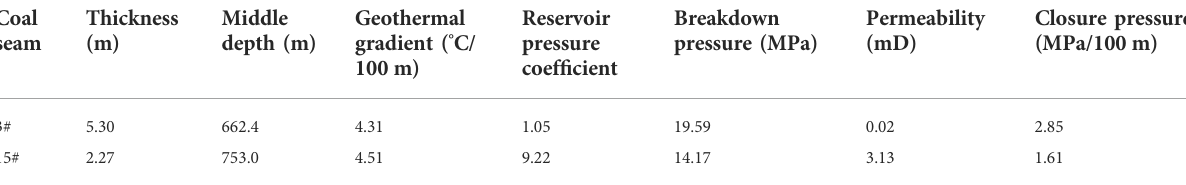
TABLE 3 Injection/pressure drop well testing and in-situ stress test of Well —